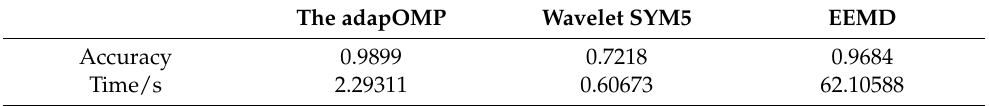
Table 1. Performance of different methods of extracting harmonic